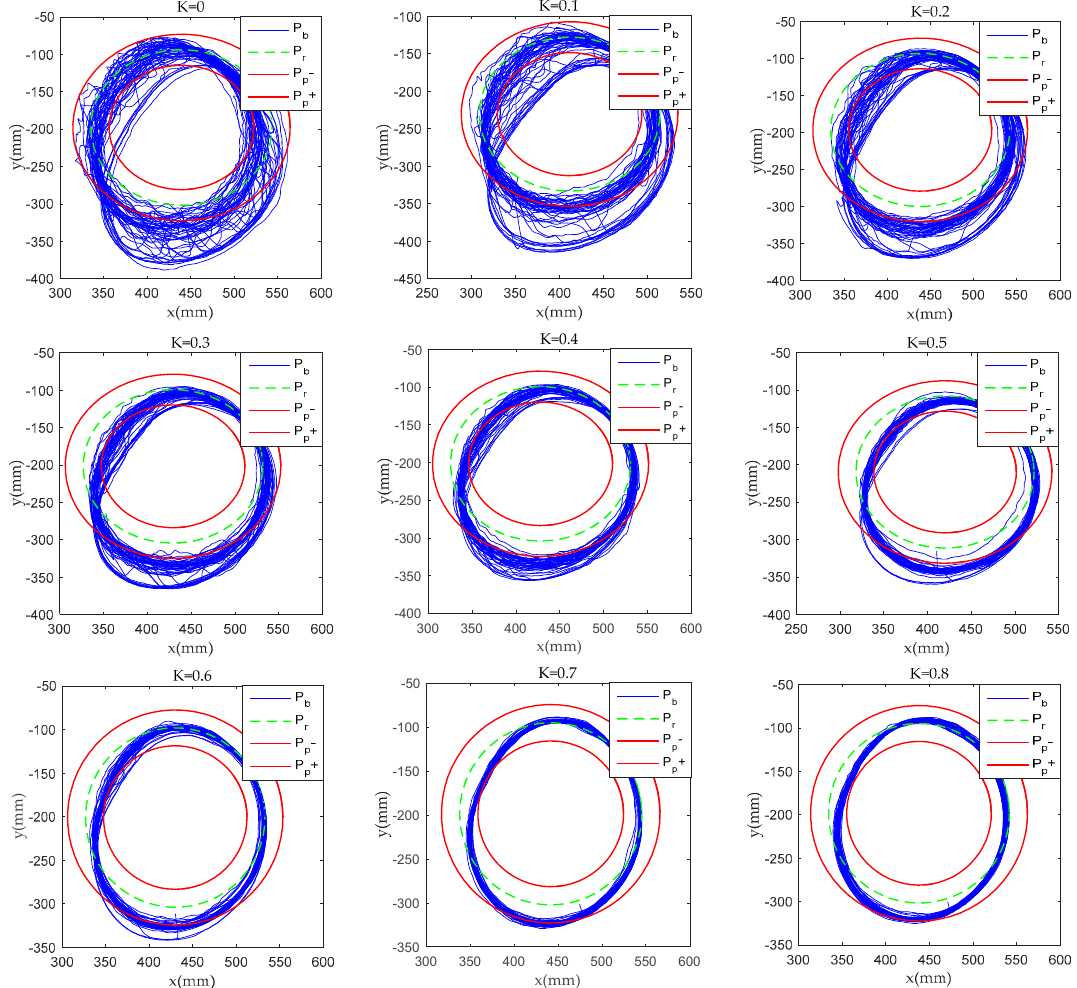
Figure 10. Terminal position during different difficulty tasks training.